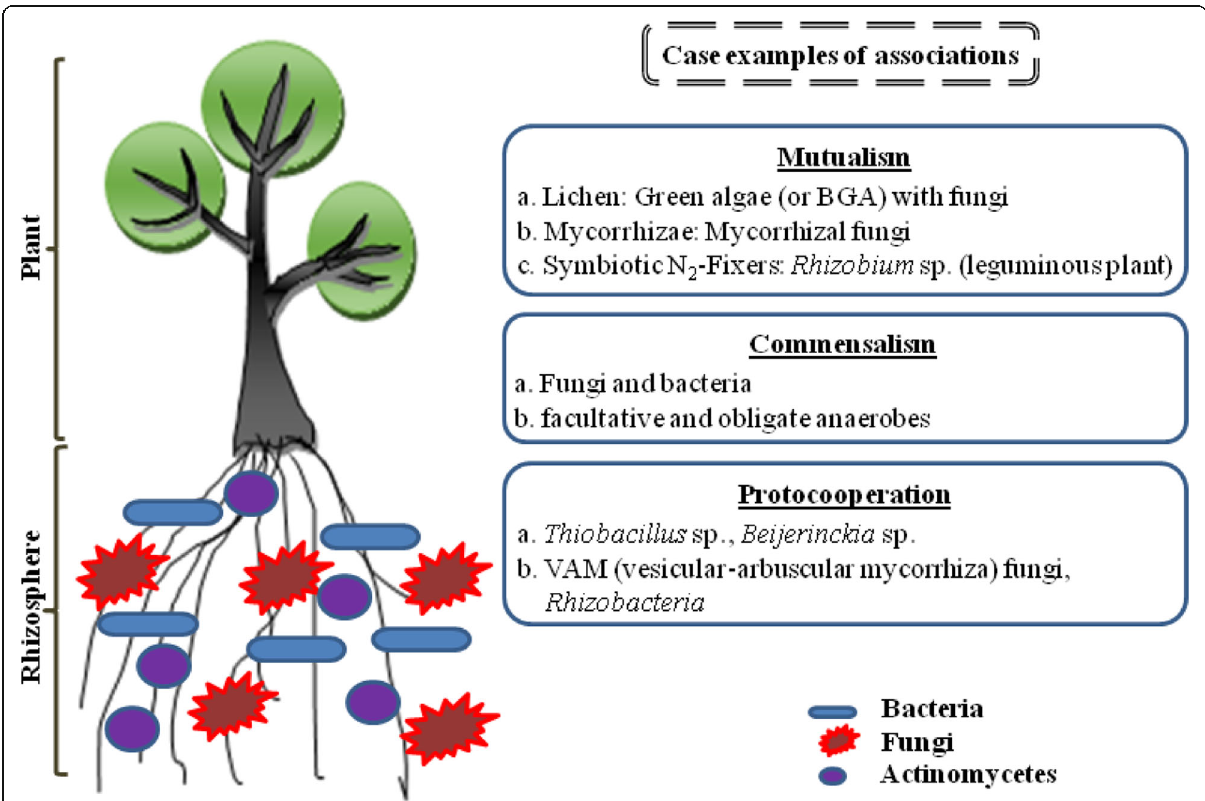
Fig. 1 The various mechanisms of action by EMs for plant growth and